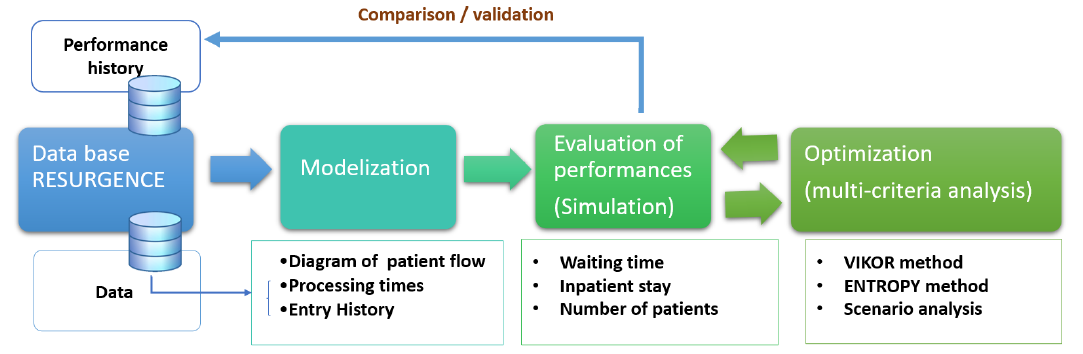
Figure 1. Simulation-based optimization